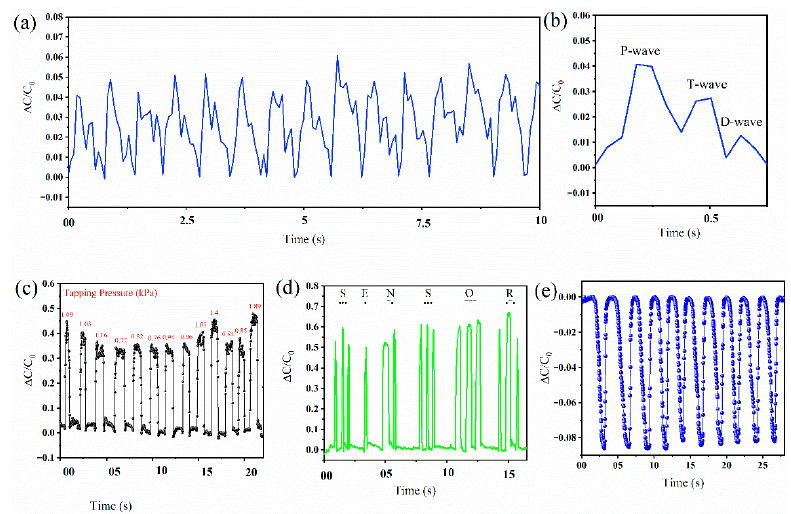
Figure 6. Application of the MWCNT-PDMS-based sensor for real − time pressure monitoring. ( a ) Real-time monitoring of arterial pulse waveforms from the wrist artery. ( b ) Single pulse waveform showing P − wave, T − wave, and D − wave. ( c ) Detection of finger tapping with irregular intervals. ( d ) Generation of Morse code for signal generation with long and short pressing on the sensor. ( e ) The capability of proximity sensing for hands-free applications.